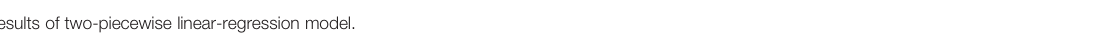
One linear-regression model